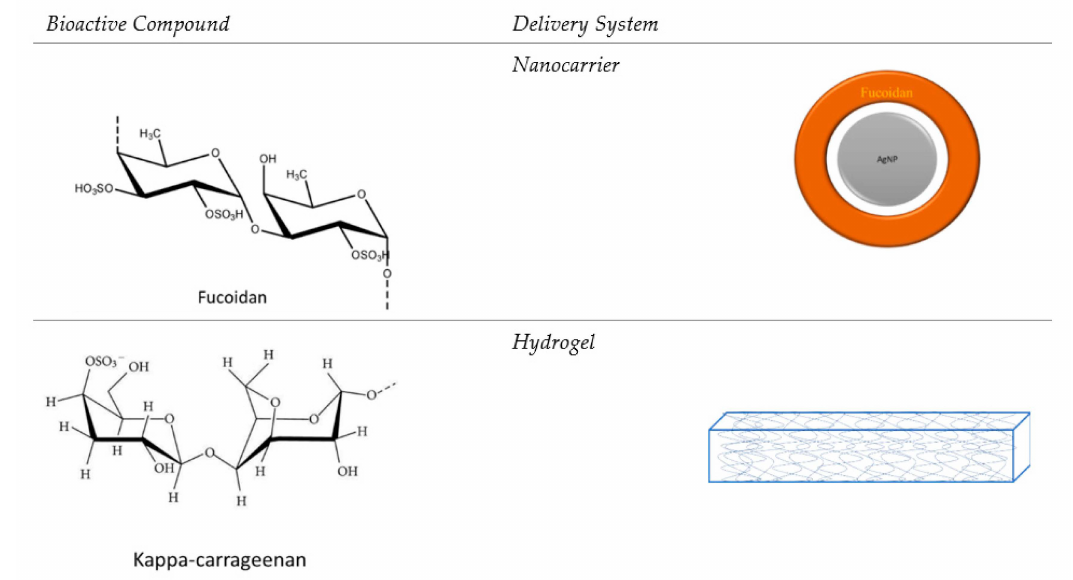
Figure 3. The bioactive compounds and the most representative delivery